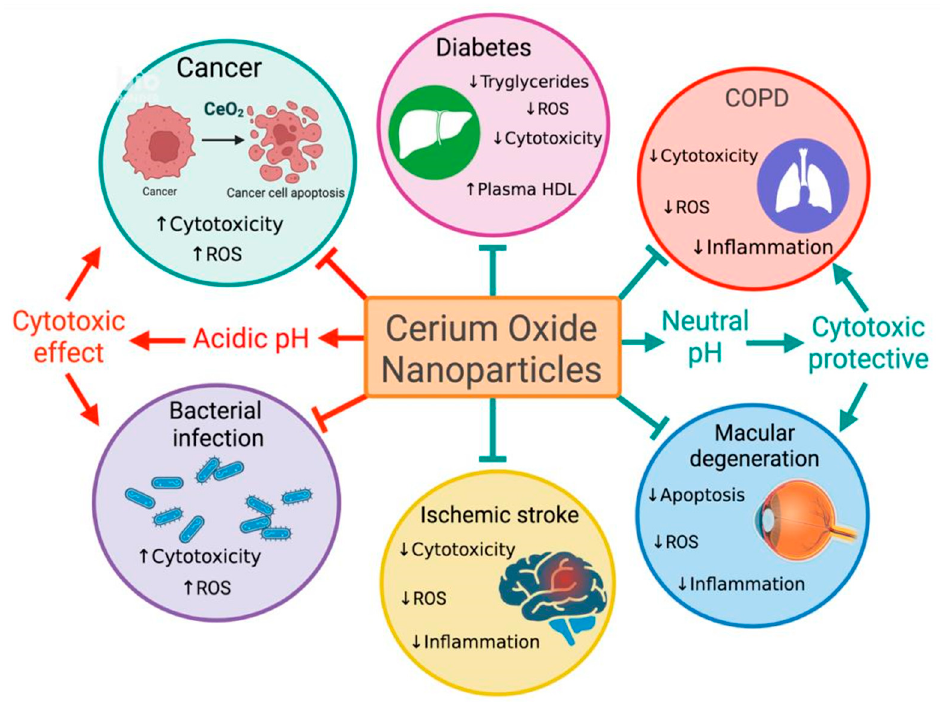
Figure 6. Graphical depiction of the various biomedical applications of cerium oxide nanoparticles as therapies for a wide range of pathologies including cancer, diabetes, cardiovascular pulmonary disease, macular degeneration, ischemic stroke and bacterial infection due to the bifunctional nature of CeO 2 . In acidic conditions the antioxidant ability of CeONPs is lost, behaving instead much like a strong oxidant, which may influence the oxidation of intracellular and extracellular components to induce apoptosis. This ability to become cytotoxic has been found to induce oxidative stress, could be attributed to cancer cells being more acidic than normal cells.